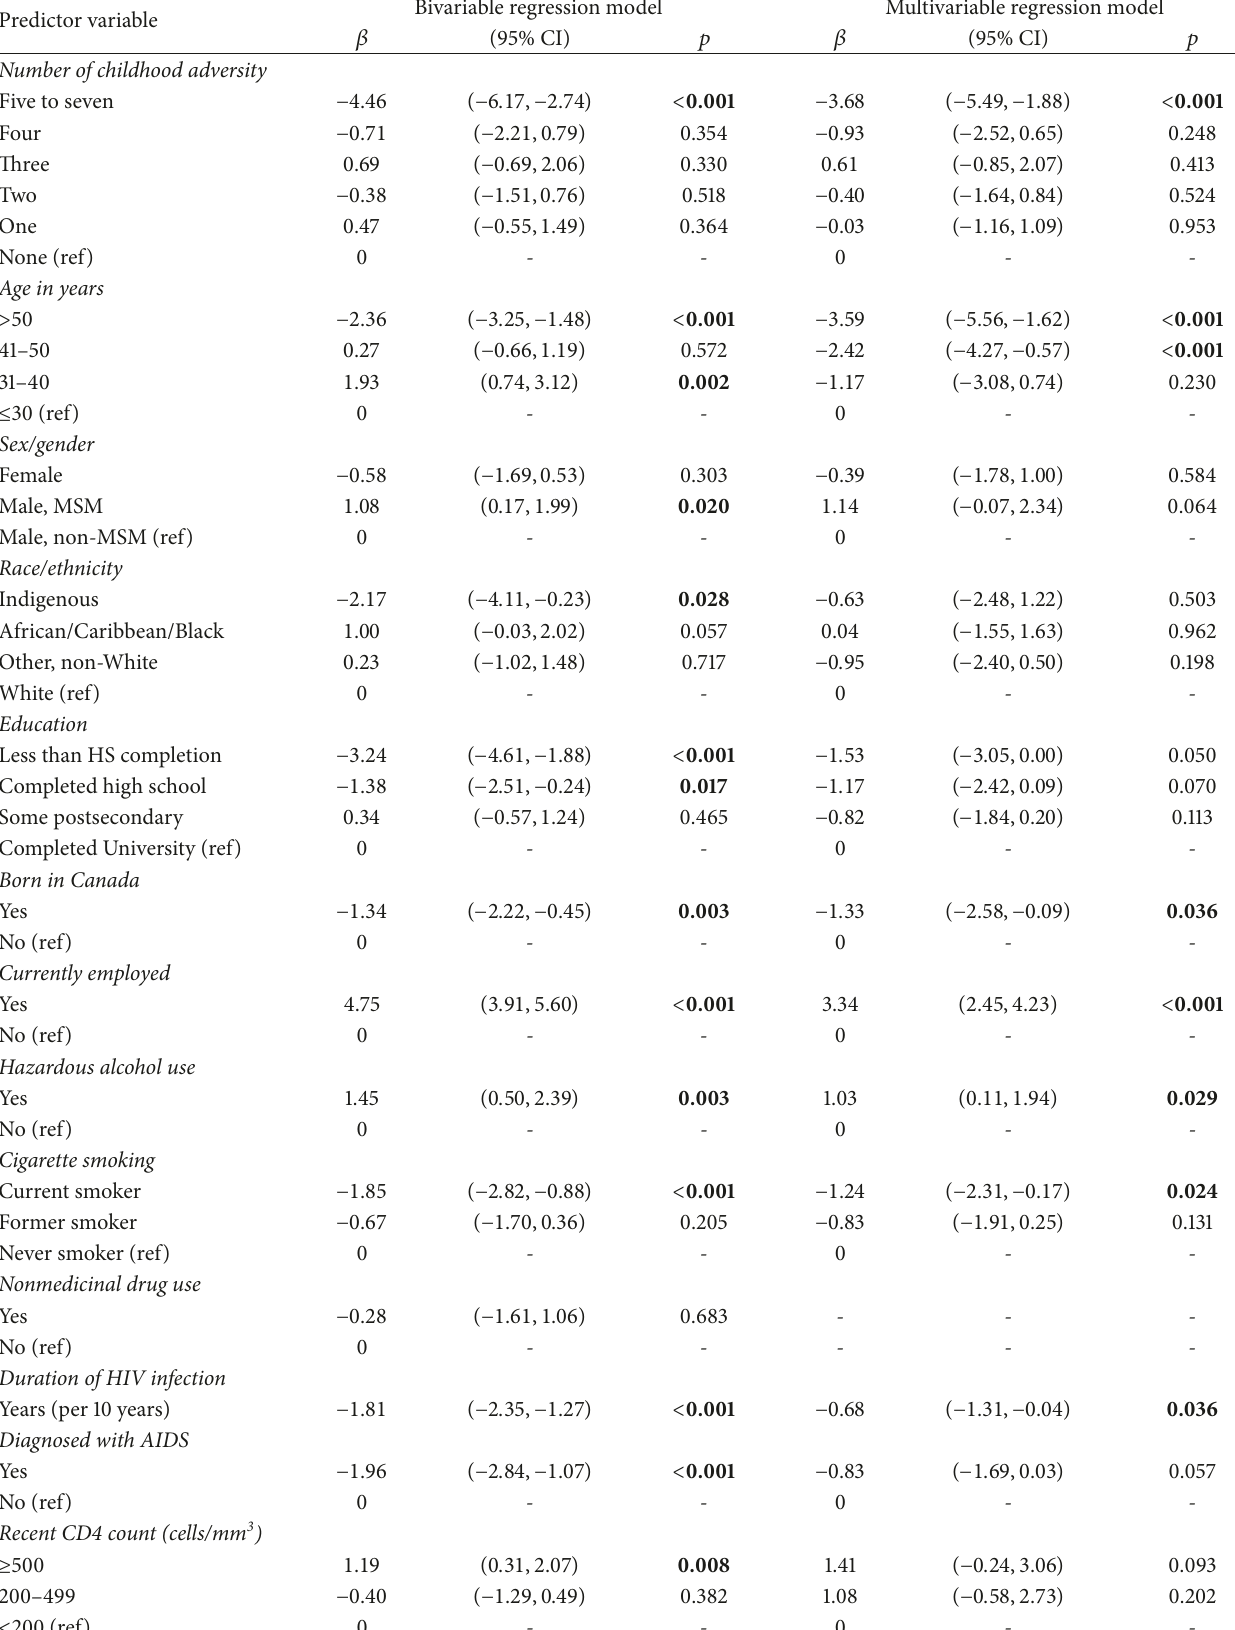
Table 4: Childhood adversities as predictors of SF-36 physical component summary (PCS) score: results from bivariable and multivariable linear regression